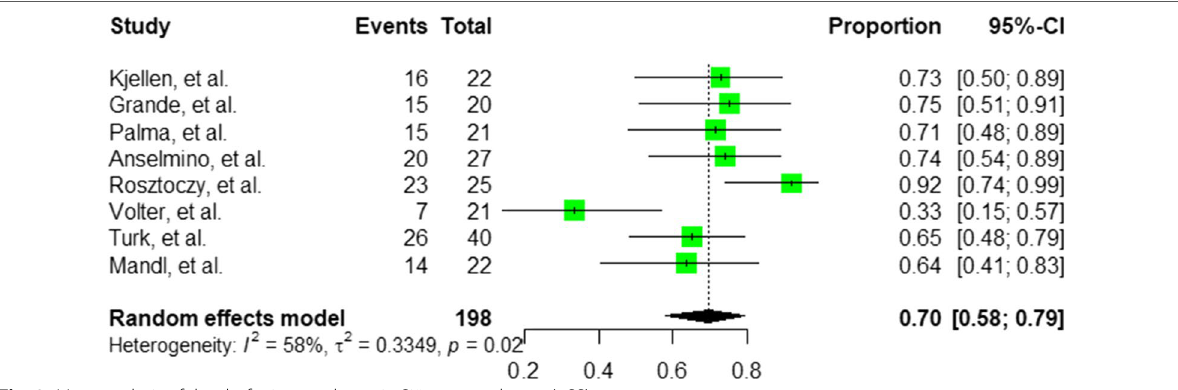
Fig. 3 Meta‑analysis of the dysfagia prevalence in Sjögren syndrome (pSS)